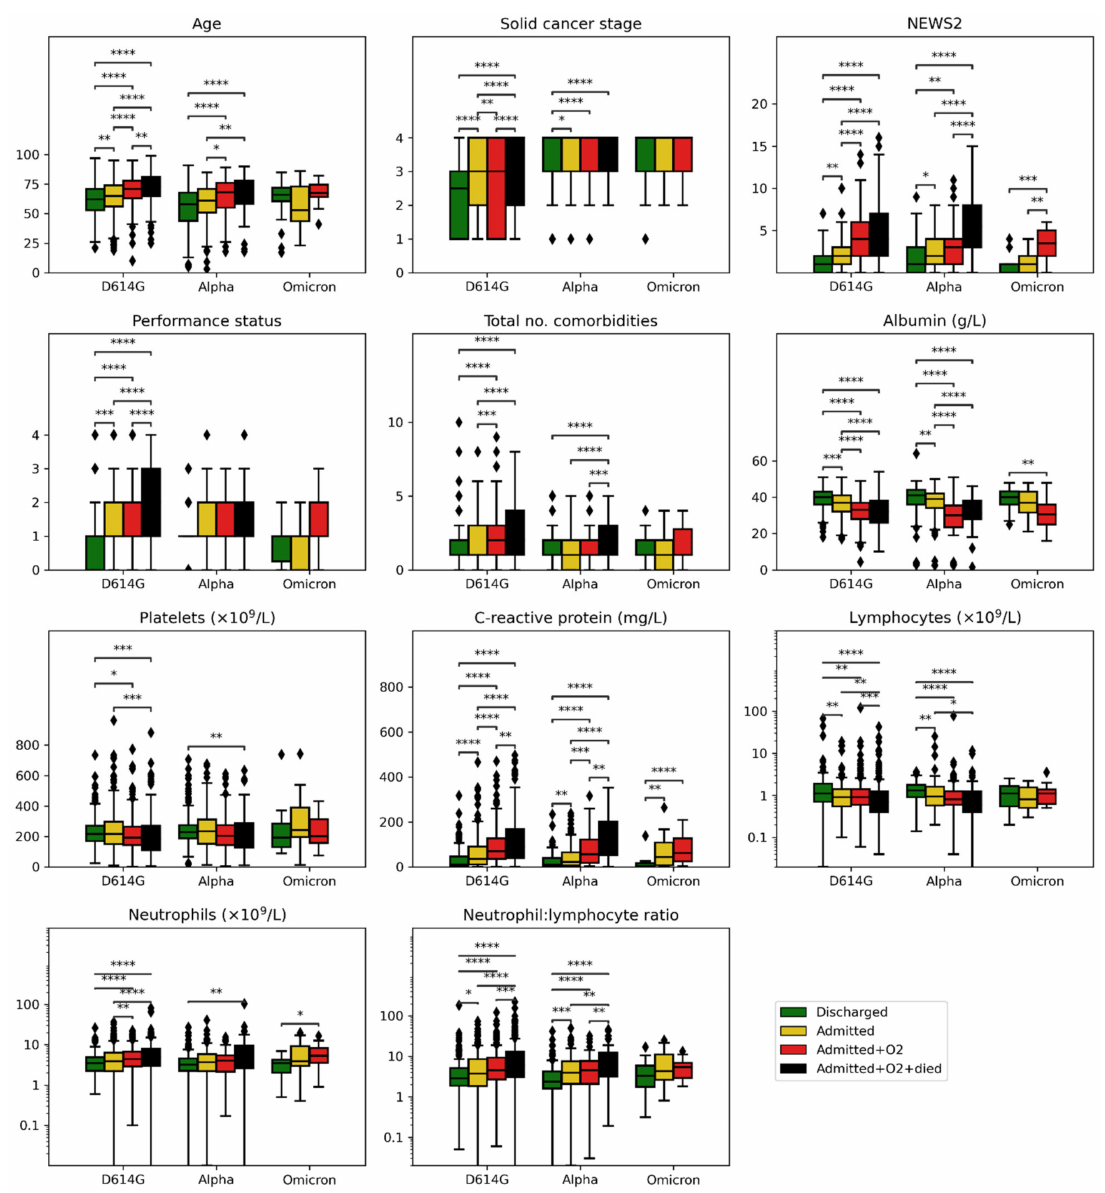
Figure 1. Known features associated with COVID-19 severity, compared during different waves and stratified by outcome. Statistically significant differences between features within the waves were marked by: ****— p < 0.0001, ***— p < 0.001, **— p < 0.01, *— p < 0.05; Mann–Whitney U and Chi 2 tests were used for numeric and categorical (solid cancer stage and performance status) features, accordingly; p values were adjusted using the Benjamini–Hochberg